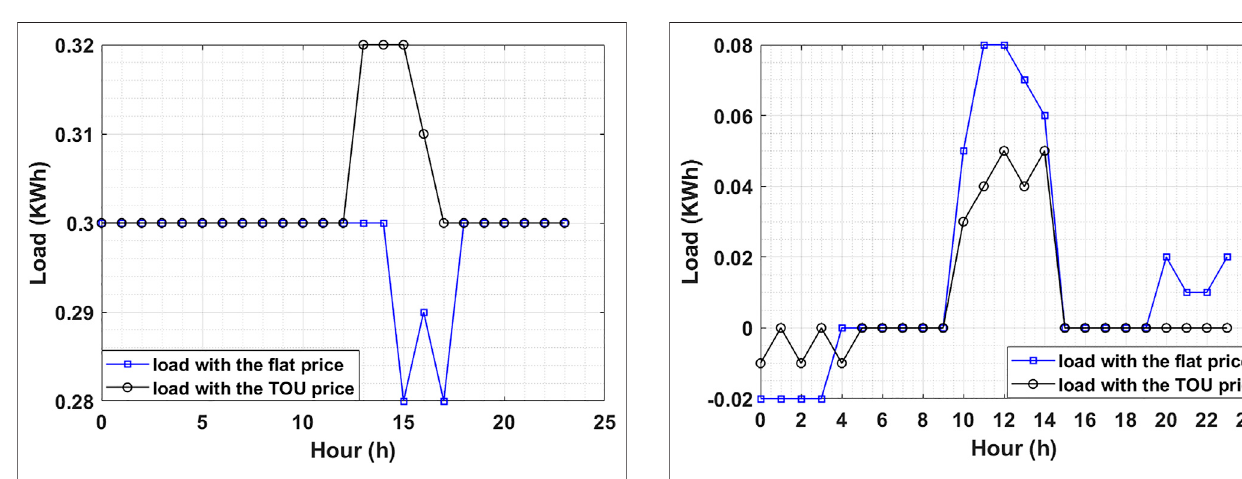
FIGURE 5 | Load of charging pile between the fl at price and TOU price. FIGURE 6 | Load of storage battery between the fl at price and